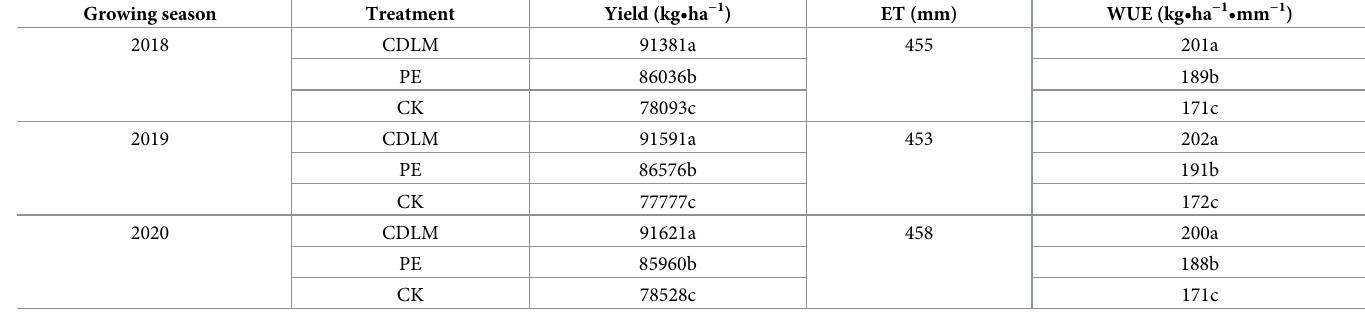
Table 3. The silage corn yields and water use efficiency (WUE) under CDLM, PE films and CK in 2018, 2019, and 2020. Different letters (a, b, and c) within a column indicate significant differences between treatments in a year (p < 0.05). Growing season